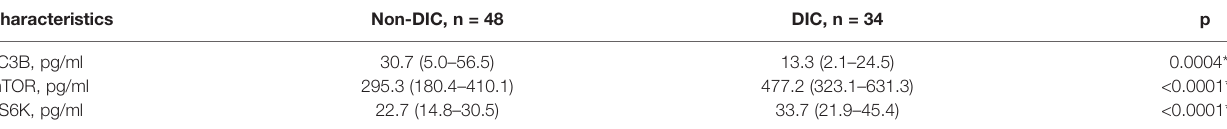
TABLE 7 | Levels of biomarkers of autophagy in different groups.